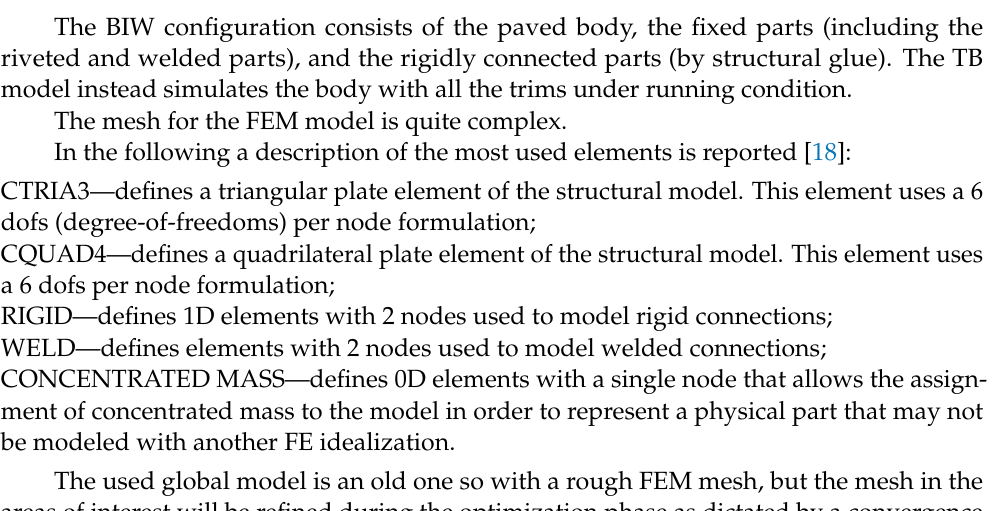
Figure 2. Trimmed Body configuration.